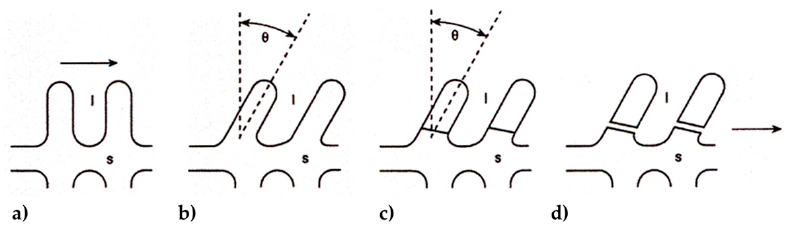
Figure 2. Schematic model of fragmentation mechanism: ( a ) undeformed dendrite, ( b ) after bending, ( c ) dislocation rearrangement to give grain boundary, and ( d ) grain boundary wetting [35].